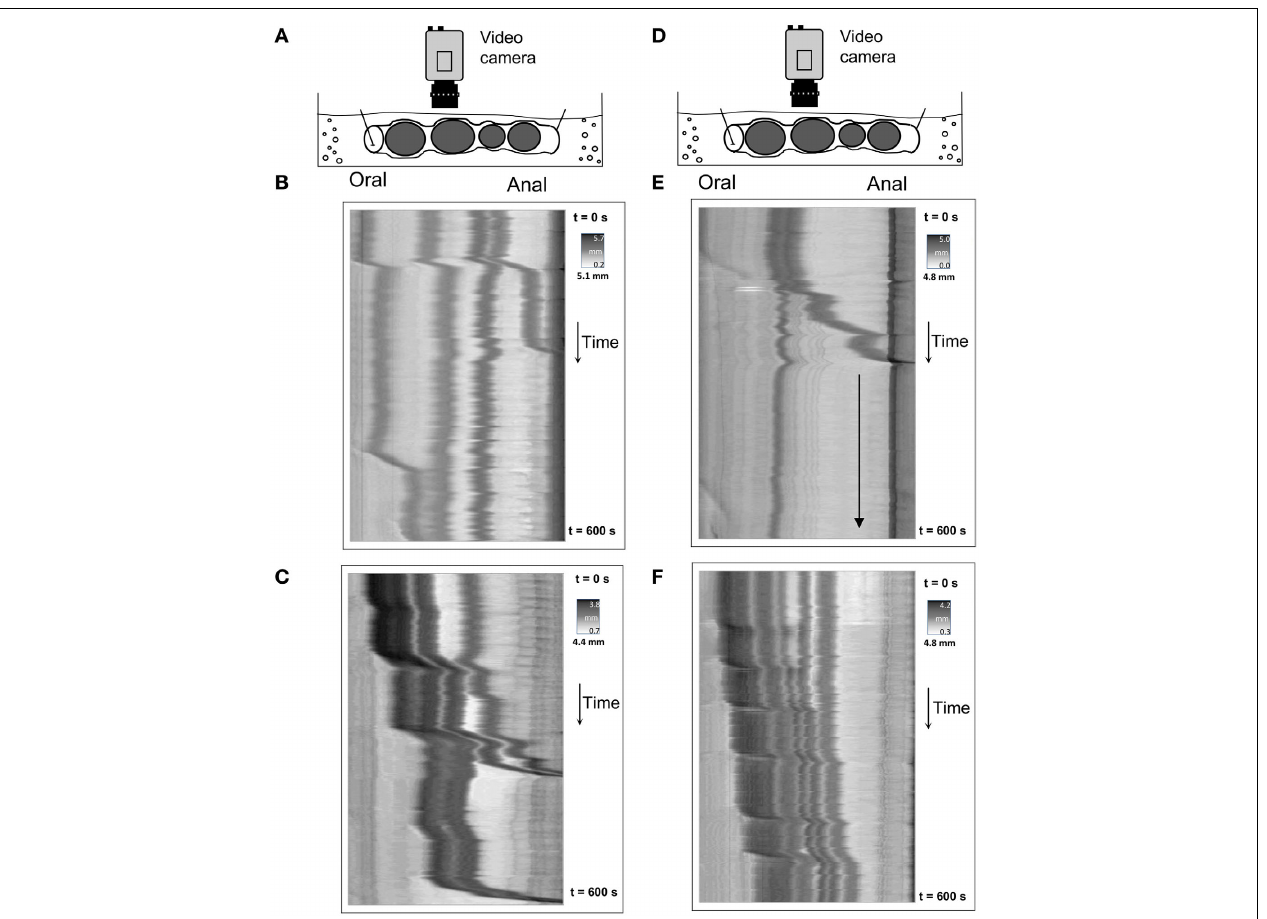
FIGURE 2 | Spatiotemporal maps of colonic circumferential wall diameter in 4 separate mice, showing propulsion of natural pellets in an aboral direction along the full length of isolated colon. (A,D) are diagrammatic representations of the preparations of colon that contain endogenous fecal pellets and were used to record changes in circumferential diameter by a video camera mounted directly above the